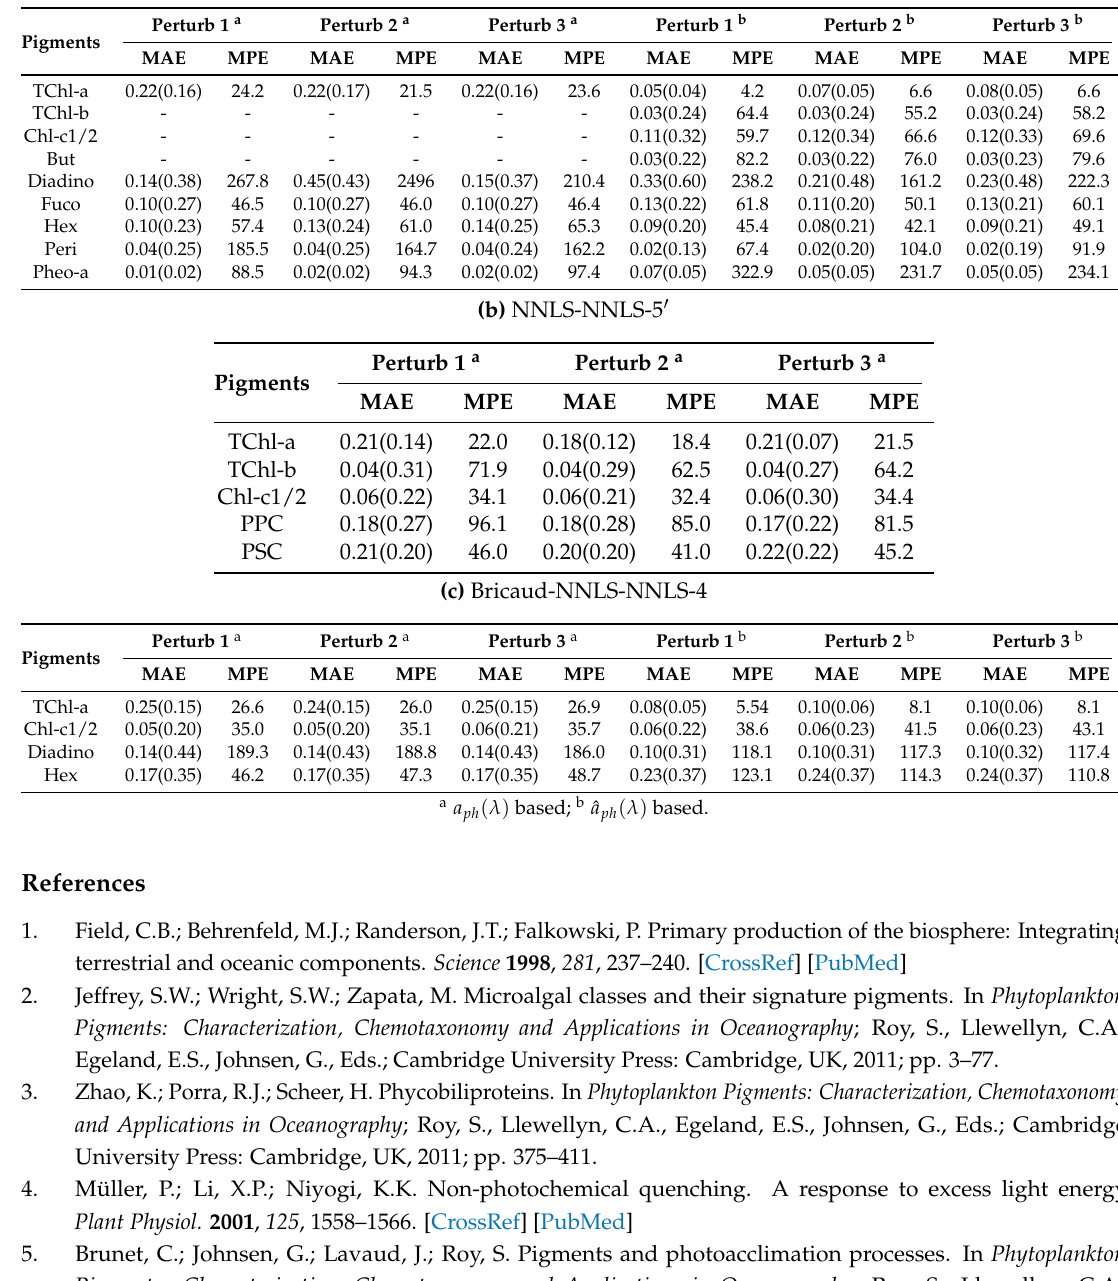
Table A1. Statistics of phytoplankton pigment retrieval using NNLS-NNLS based on leave-one-out cross-validation. MAE is in mg m − 3 (values outside the parentheses were calculated with linear-scale values, while inside the parentheses with log10-scale values) and MPE in %. “Perturb 1, 2 and 3” represent the input data with perturbations of pigment concentrations solely, a ph ( λ ) solely and both,